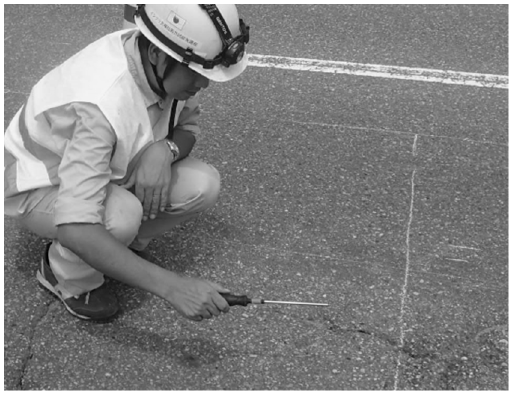
Figure 5. Steel-ball